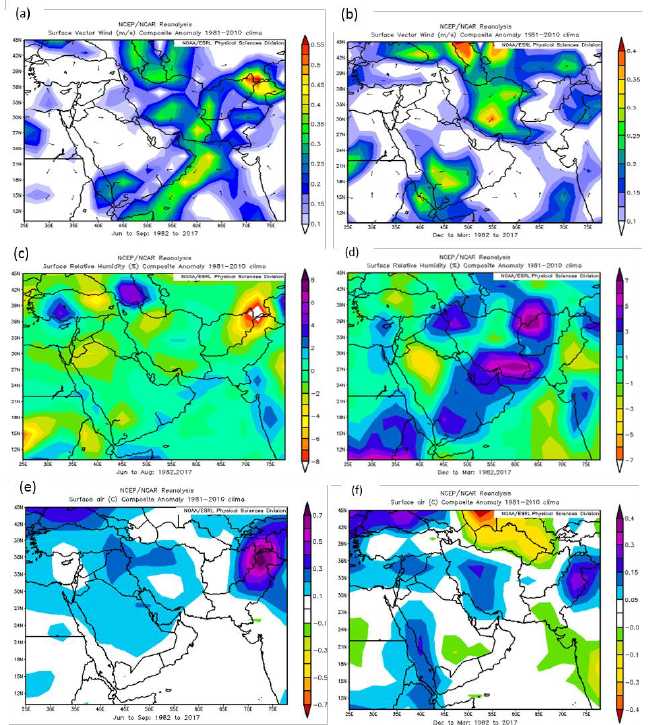
Figure 6. Thirty three years of wind speed, relative humidity, and air temperature averaged anomalies at surface level, ( a ) vector wind in summer, ( b ) vector wind in winter, ( c ) relative humidity in summer ( d ) relative humidity in winter, ( e ) air temperature in summer, and ( f ) air temperature in winter over the Middle East, Latitude 12 ° –45 ° N, and Longitude 25 ° –75 ° E, with the study area located in the middle of the map.